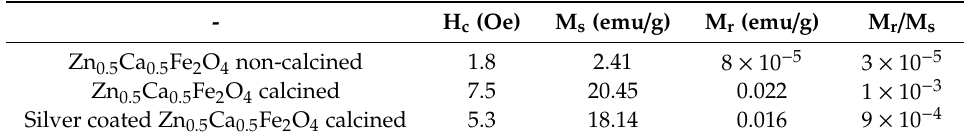
Table 4. Coercive field (H c ), saturation magnetization (M s ), remnant magnetization (M r ) and ratio M r / M s for zinc / calcium ferrites at room